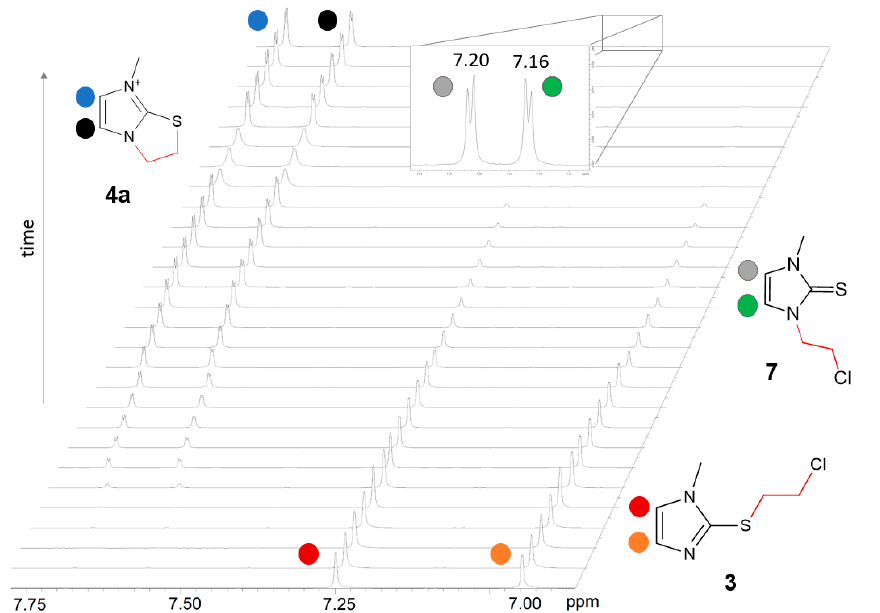
Figure 4. Imidazole region of time-dependent 1 H NMR spectra in DMSO- d 6 for the mixture of 3 , 4a, and 7 .Imidazole protons of: 3 (presented in orange and red), 7 (presented in green and grey) and 4a (presented in black and blue).